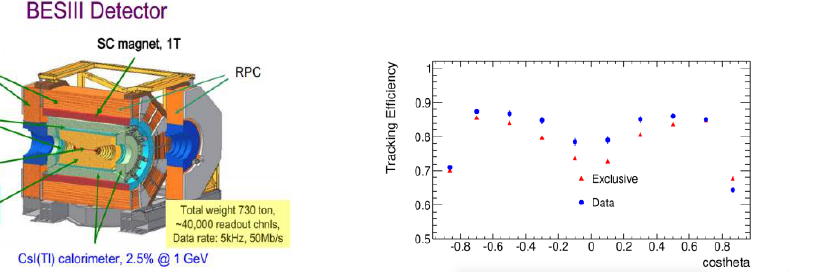
Fig. 1. The BESIII Detector. Fig. 2. The tracking efficiency of the  - along cos